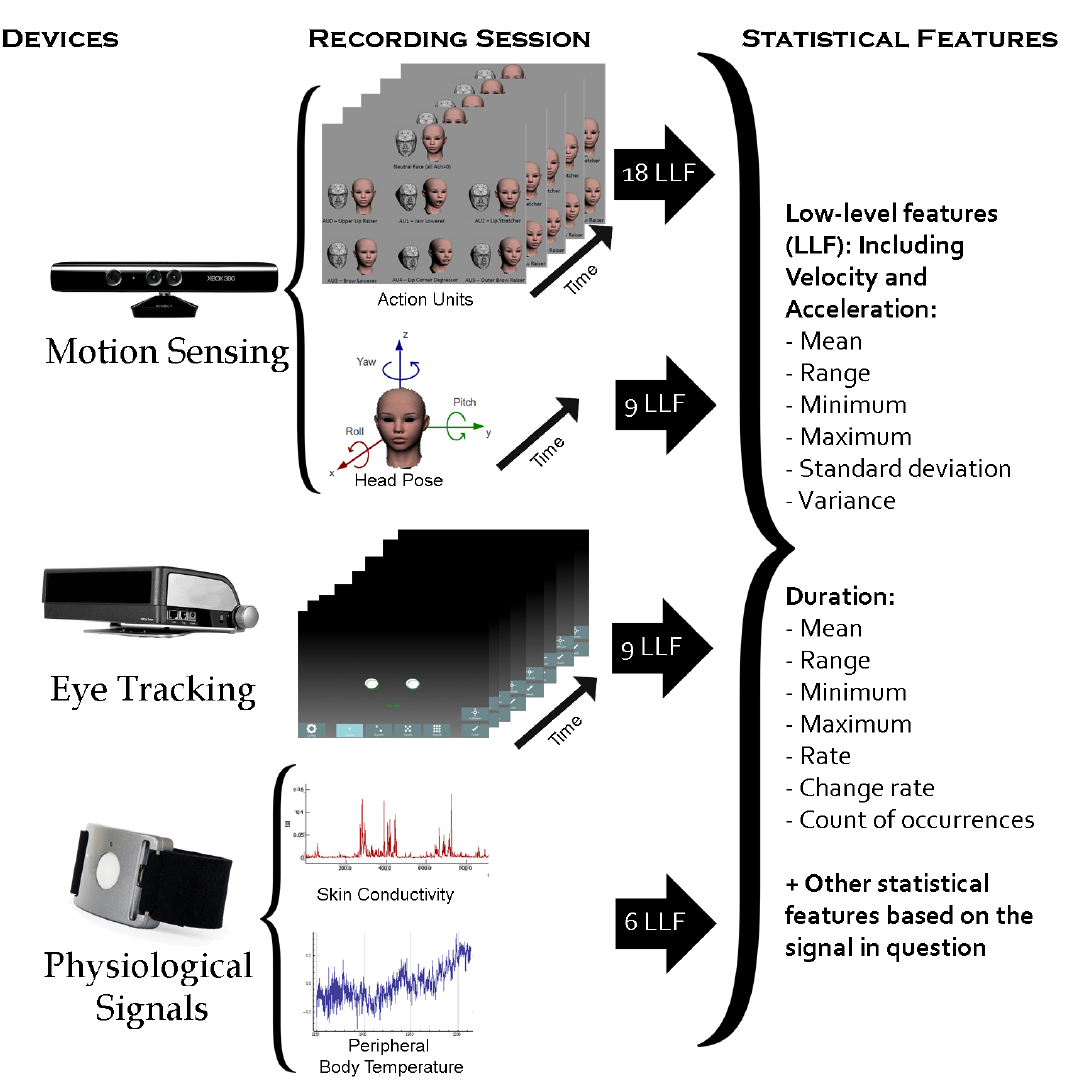
Figure 5. Summary of feature extraction